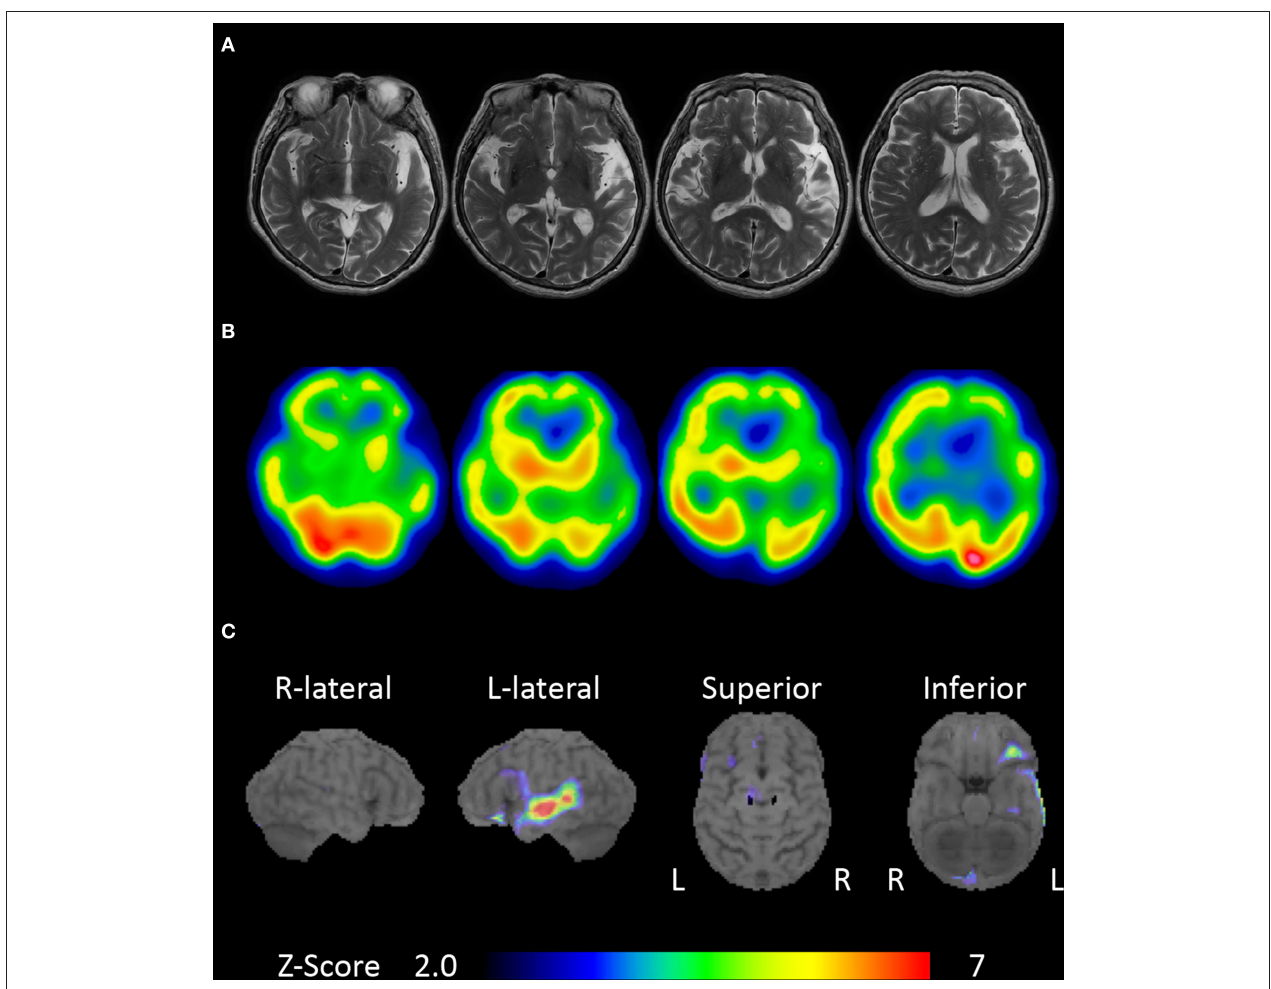
FIGURE 1 | Brain magnetic resonance imaging and single-photon emission computed tomography (SPECT). (A) Brain magnetic resonance imaging showing left-sided predominant atrophy of the perisylvian area. (B) N -Iso-propyl- p -[123I] iodoamphetamine SPECT showing left-sided predominant hypoperfusion of the bilateral frontal and temporal lobes. (C) Brain SPECT analyzed with 3D stereotactic surface projections (SSPs) showing relative hypoperfusion mainly in the left superior temporal and inferior frontal